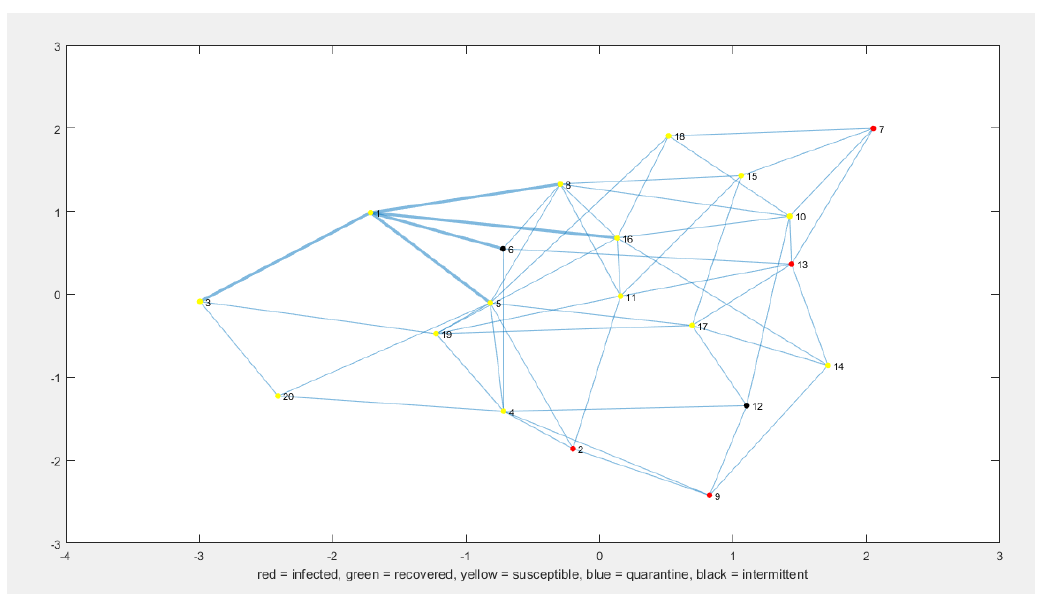
Figure 8. Node-state graph at time t = 3. The dynamic node 1 has been selected to move after the next time interval, hence its current edges are